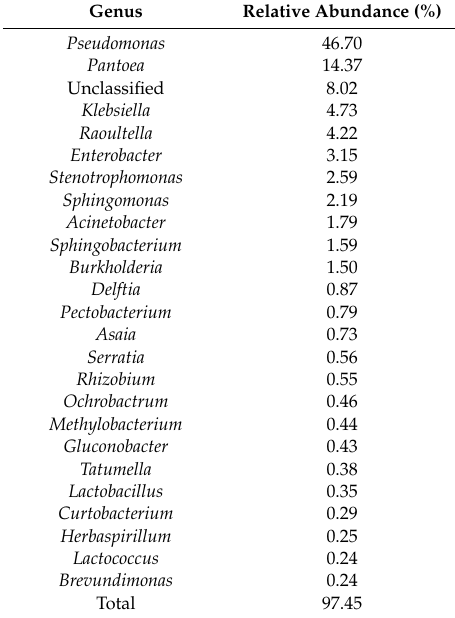
Table 1. Relative abundance of the top 25 bacterial genera identified in fresh forage by 16S rDNA